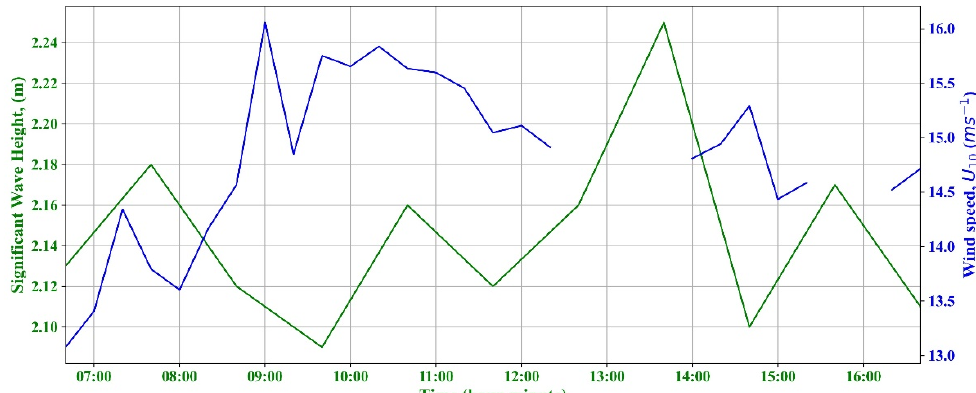
Figure 1. ( a ) Route of the cruise (red dots denote the stations); ( b ) schematic of cameras fields of view: the FLIR (blue) is an IR camera, the GoPro (green) is a visible camera.